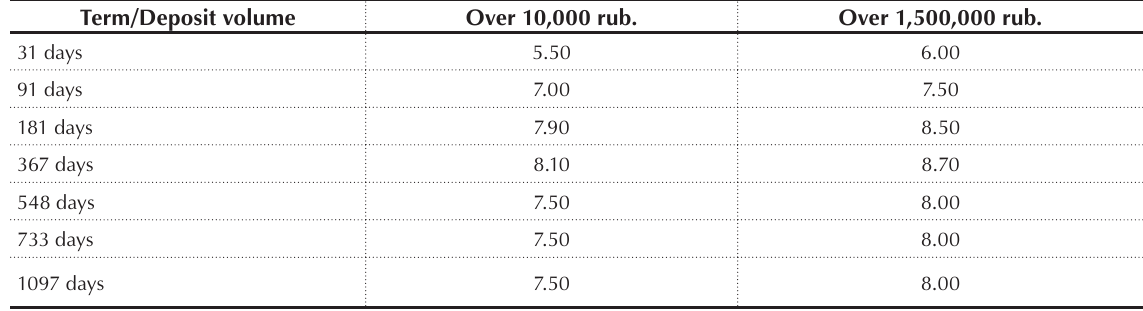
Table (cid:1009). (cid:18)(cid:381)(cid:373)(cid:393)(cid:258)(cid:396)(cid:349)(cid:400)(cid:381)(cid:374)(cid:3)(cid:381)(cid:296)(cid:3)(cid:410)(cid:346)(cid:286)(cid:3)(cid:271)(cid:258)(cid:400)(cid:349)(cid:272)(cid:3)(cid:272)(cid:381)(cid:374)(cid:282)(cid:349)(cid:415)(cid:381)(cid:374)(cid:400)(cid:3)(cid:296)(cid:381)(cid:396)(cid:3)(cid:410)(cid:286)(cid:396)(cid:373)(cid:3)(cid:396)(cid:286)(cid:410)(cid:258)(cid:349)(cid:367)(cid:3)(cid:282)(cid:286)(cid:393)(cid:381)(cid:400)(cid:349)(cid:410)(cid:400)(cid:3)(cid:381)(cid:296)(cid:3)(cid:367)(cid:286)(cid:258)(cid:282)(cid:349)(cid:374)(cid:336)(cid:3)(cid:271)(cid:258)(cid:374)(cid:364)(cid:400)(cid:3)(cid:296)(cid:381)(cid:396)(cid:3)(cid:410)(cid:346)(cid:286)(cid:3)(cid:258)(cid:373)(cid:381)(cid:437)(cid:374)(cid:410)(cid:3) (cid:381)(cid:296)(cid:3)(cid:1006)(cid:1009)(cid:1004)(cid:3)(cid:410)(cid:346)(cid:381)(cid:437)(cid:400)(cid:258)(cid:374)(cid:282)(cid:3)(cid:396)(cid:437)(cid:271)(cid:856)(cid:3)(cid:258)(cid:400)(cid:3)(cid:381)(cid:296)(cid:3)(cid:94)(cid:286)(cid:393)(cid:410)(cid:286)(cid:373)(cid:271)(cid:286)(cid:396)(cid:3)(cid:1005)(cid:1004)(cid:853)(cid:3)(cid:1006)(cid:1004)(cid:1005)(cid:1010)(cid:853)(cid:3)(cid:1081)(cid:3)(cid:393)(cid:286)(cid:396)(cid:3)(cid:258)(cid:374)(cid:374)(cid:437)(cid:373) Term/Deposit volume Over 10,000